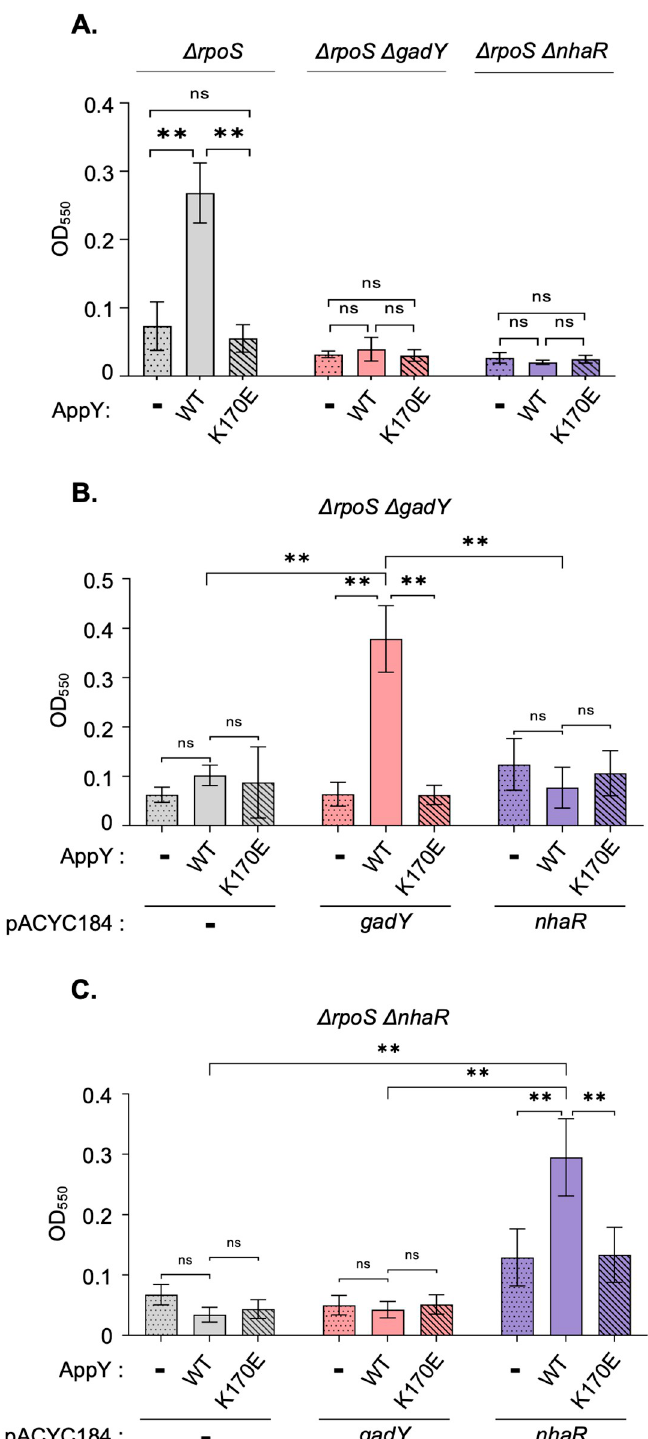
Fig 4. AppY favors biofilm formation through nhaR and gadY induction. The indicated strains were grown in LB with 0.5 mM IPTG at 30˚C without shaking for 24 hours. Biofilm formation was visualized using crystal violet staining and quantified by measuring the optical density at 550 nm (OD 550 ). The mean from three replicates is presented; the error bars represent the standard deviation (SD). Statistical significance calculations were performed using a two-tailed unpaired Student’s t test (ns, not significant; �� , p-value < 0.01). A. Biofilm formation dependent on AppY, GadY